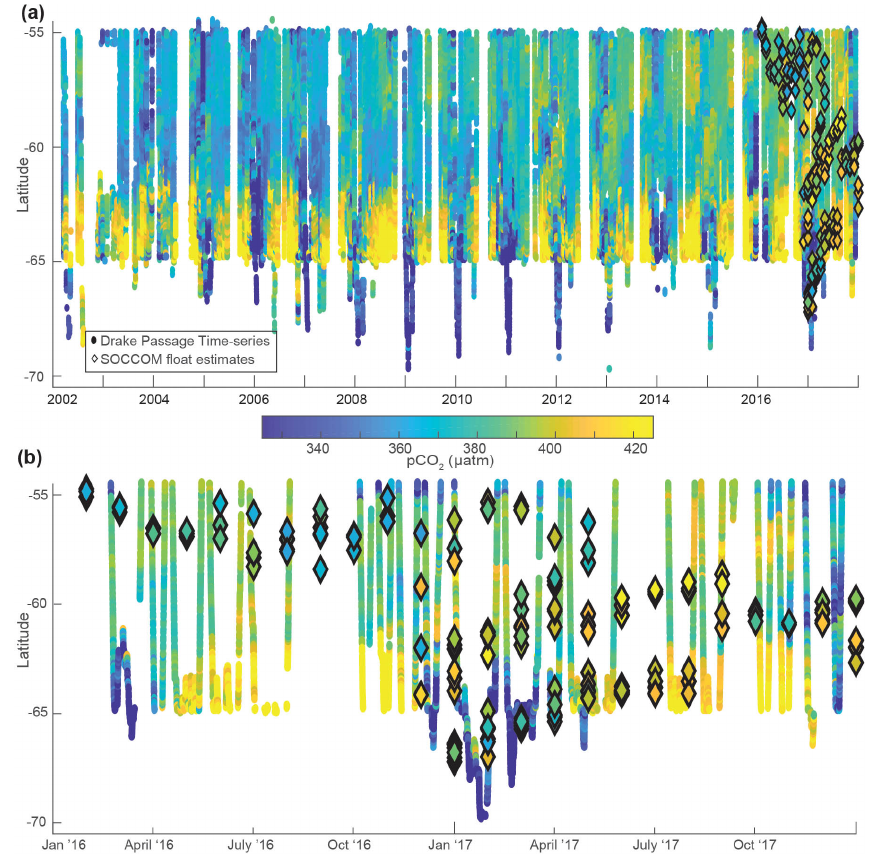
Figure 8. (a) 2002–2017 underway DPT p CO 2 observations (circles) and surface p CO 2 estimates from SOCCOM floats overlain (diamonds; µatm), plotted versus latitude. (b) Same as (a) but plotted as January 2016 to December